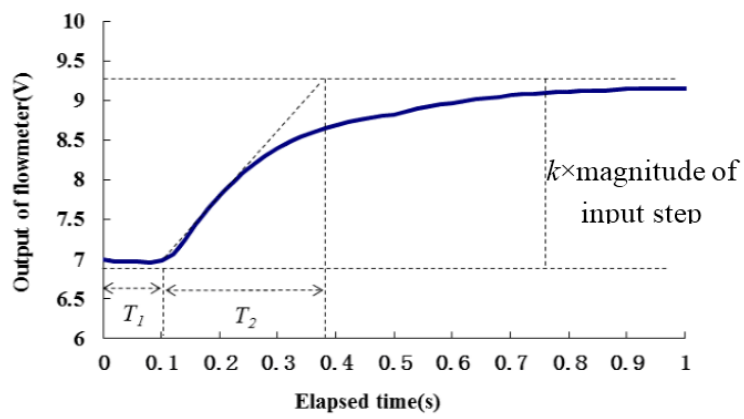
Figure 8. Open loop response to a step input P = 1200 μ s, to obtain the transfer function coefficients.